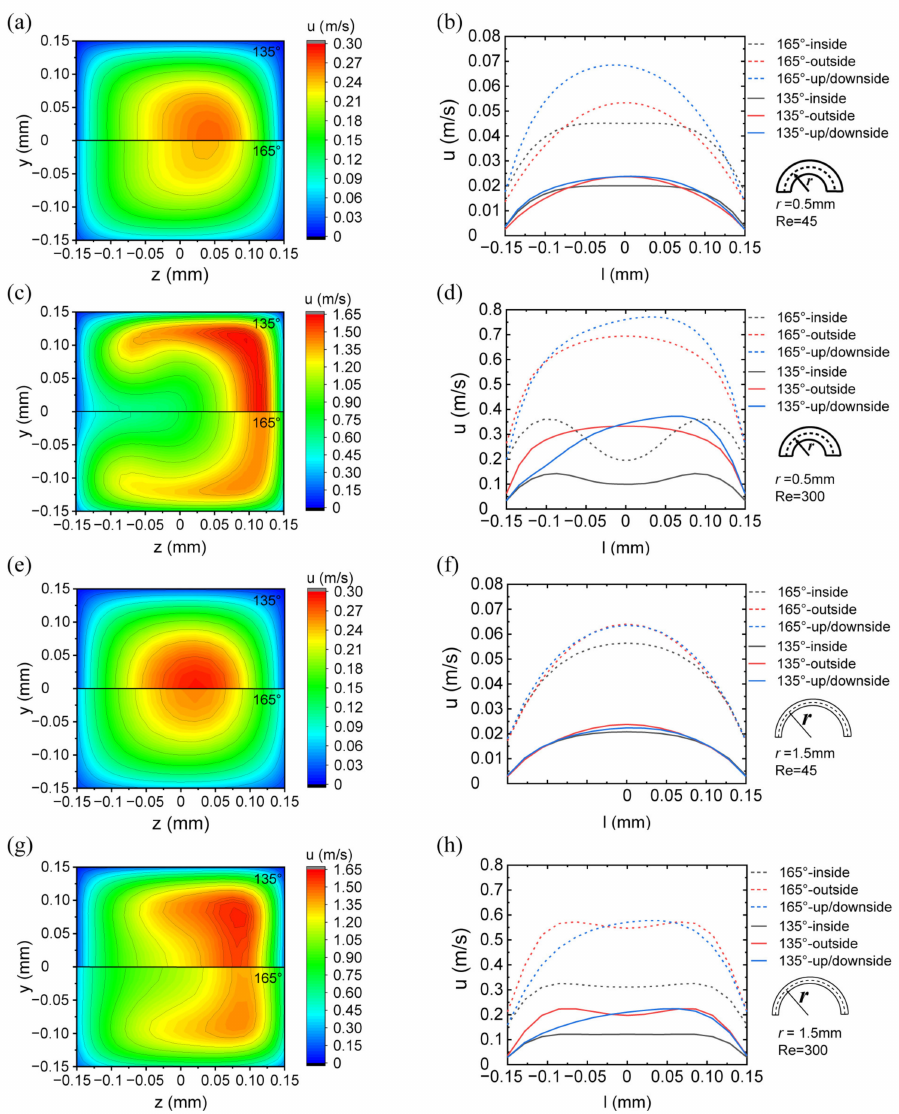
Figure 8. Three-dimensional non-uniform slip velocity distribution: velocity magnitude distribution color map for r = 0.5 mm ( a , c ) and 1.5 mm ( e , g ) and Re = 45 ( a , e ) and 300 ( c , g ), and distribution of slip velocity around the middle section of the channel for r = 0.5 mm ( b , d ) and 1.5 mm ( f , h ) and Re = 45 ( b , f ) and 300 ( d , h